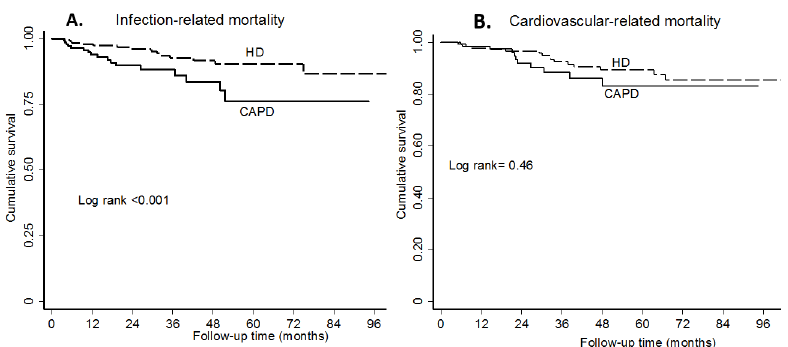
Fig 2. Kaplan-Meier survival curves cause-specific mortality according to dialysis modality. a. Infection- related mortality. b. Cardiovascular mortality.